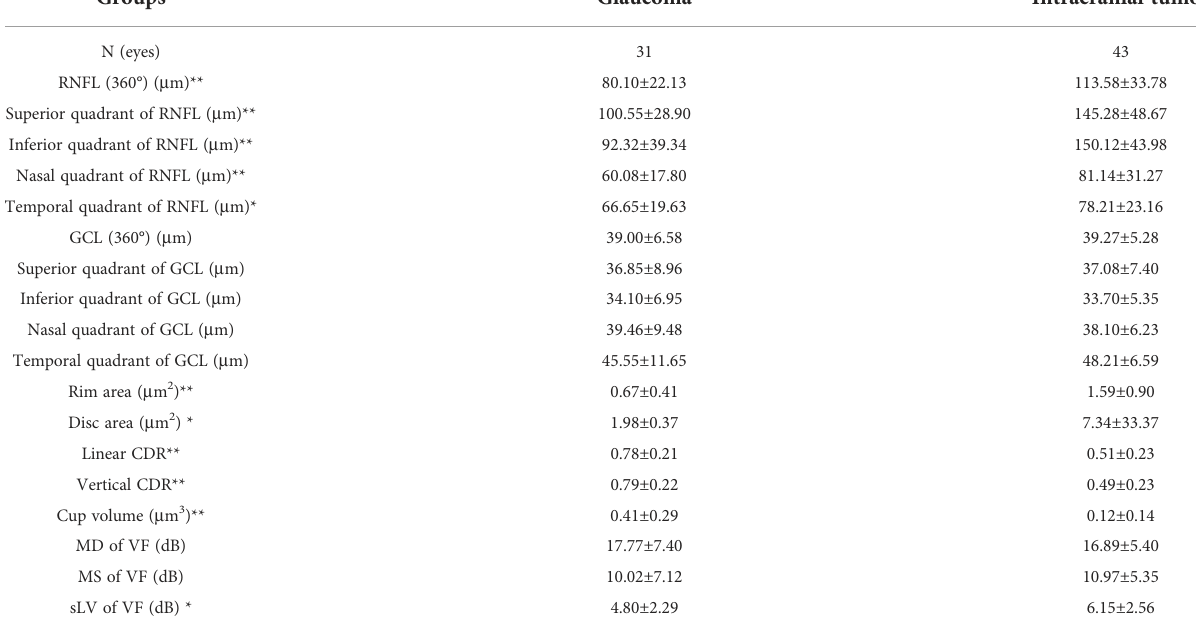
TABLE 1 Data of VF and RNFL for the glaucoma and intracranial tumor groups.